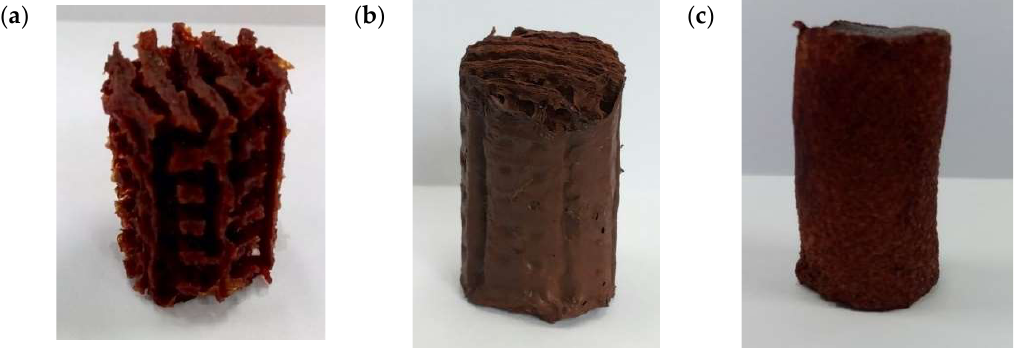
Figure 3. Image of the 3D construct ( a ) without thin wall ( b ) with thin wall ( c ) control specimen.